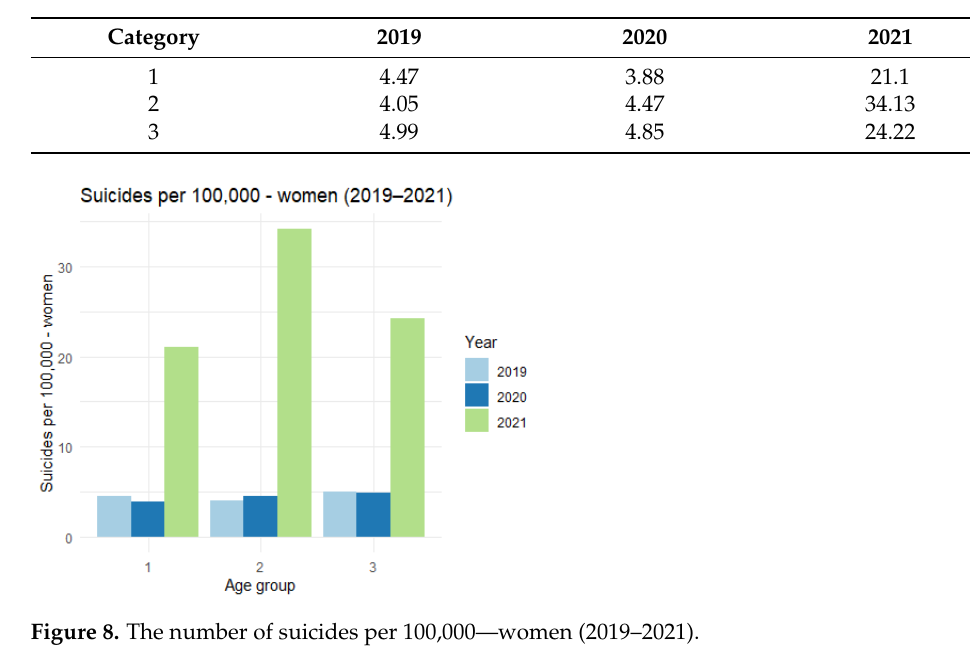
Figure 7. The number of attempted suicides per 100,000 men (2019–2021). Table 5. Number of suicides per 100,000 women (2019–2021).